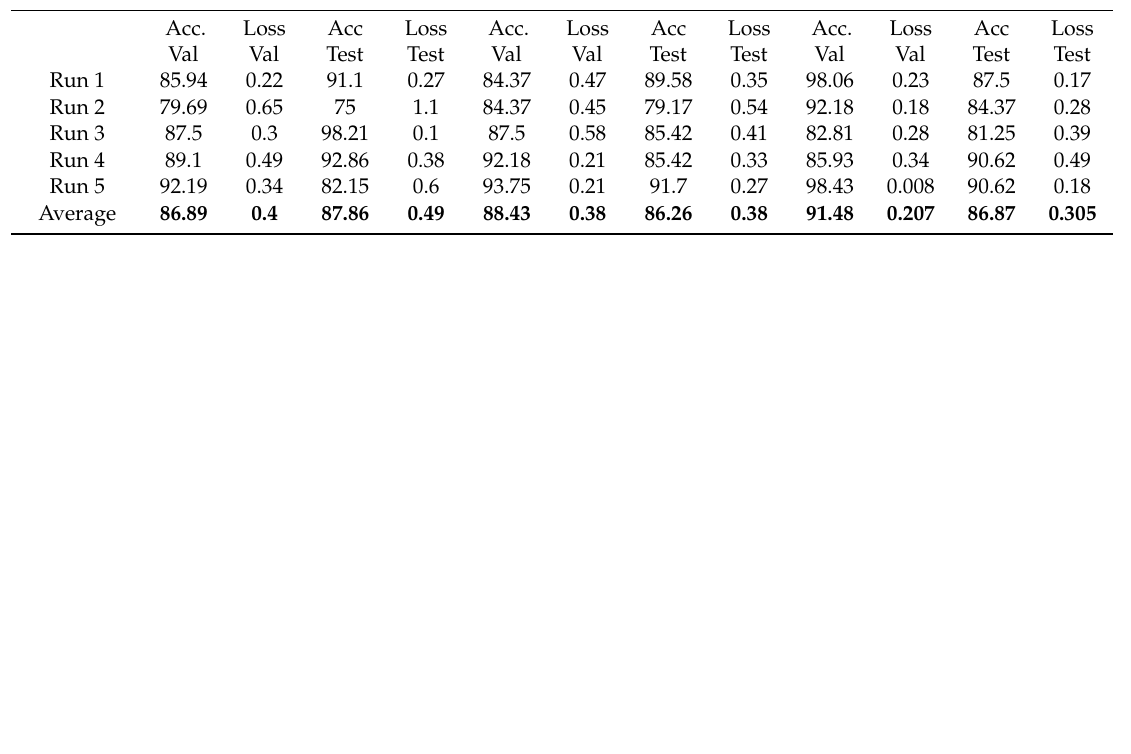
Table 3. CNN model 1 (epochs = 200, dropout = 0.2, pixel = 256 × 256) runs for different batch sizes.